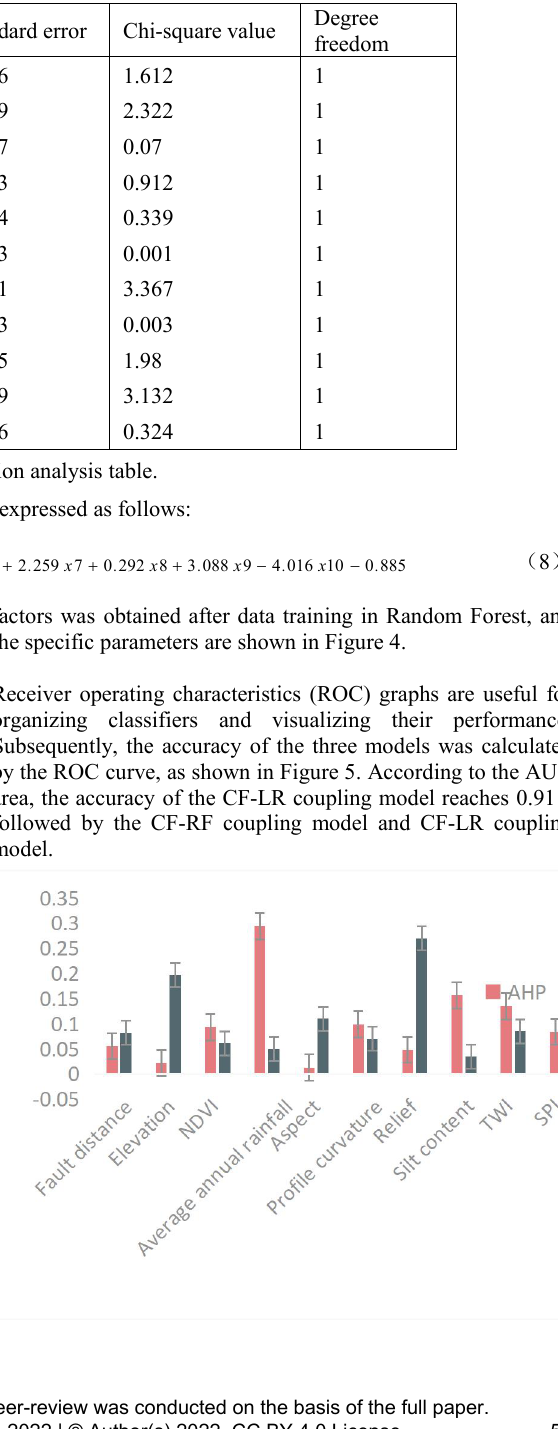
Table 3 . Judgment matrix of the second criterion layer.